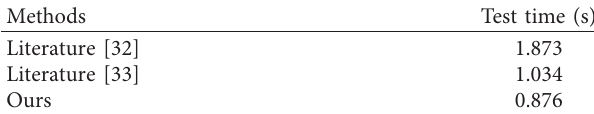
Table 1: Time performance of the three algorithms. Methods Test time